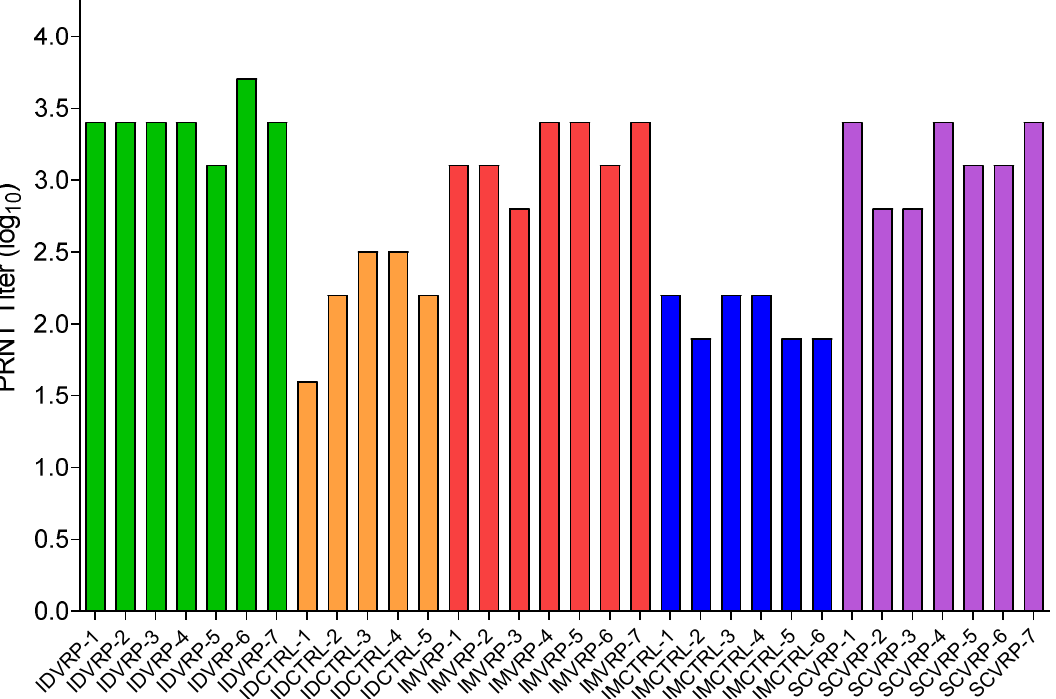
Figure 9. Neutralizing serum antibody titers after WEEV CBA87 aerosol exposure. The PRNT80 titers at the time of death for ID CTRL-1 (day 8 PE) or on day 28 PE for all other NHPs. Blood was collected and the WEEV-specific neutralizing antibody levels were measured by PRNT assay.